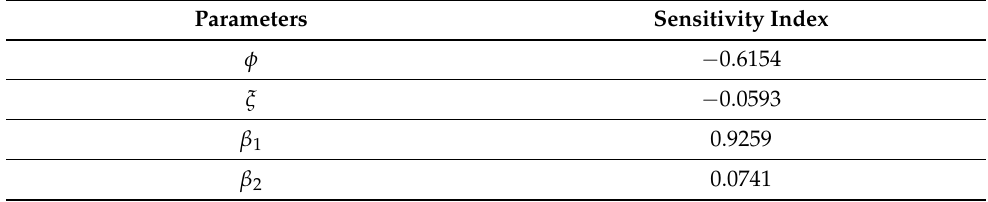
Table 2. Sensitivity indices of different parameters of system (3) corresponding to Table 3.